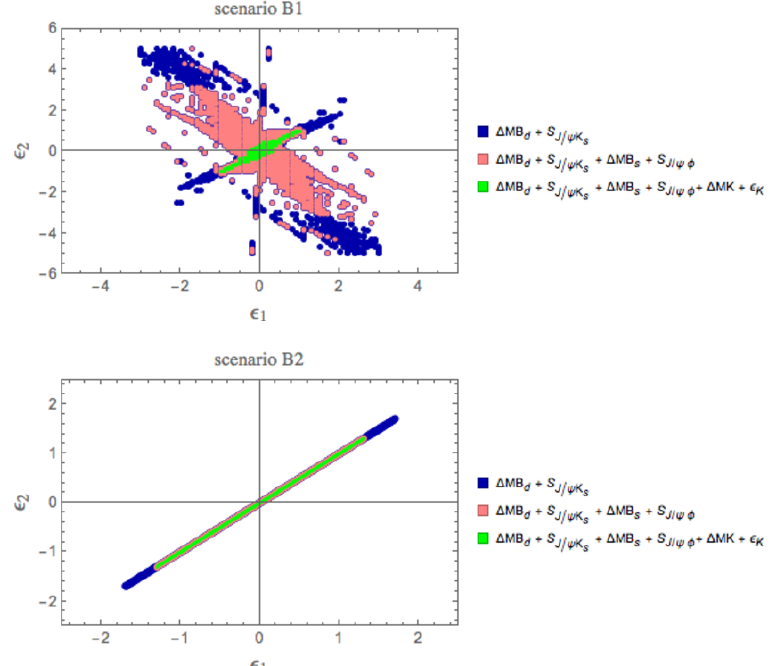
Figure 6 . Scenarios B1 (upper panel) and B2 (lower panel). Allowed region in the ( (cid:15) 1 ; (cid:15) 2 ) plane, after imposing (cid:1) F = 2 constraints, as indicated in the legend.